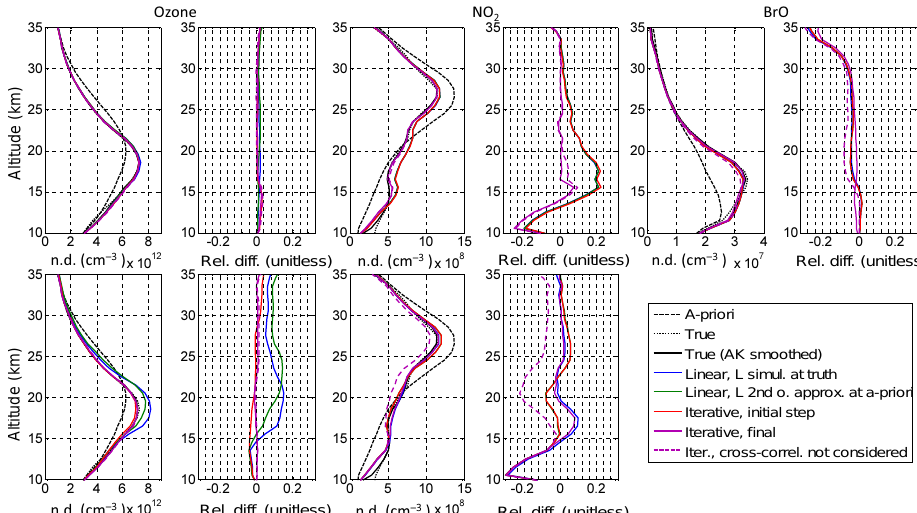
Figure 13. Odd plots (from left for ozone, NO 2 , and BrO): vertical concentration profiles retrieved by different approaches (blue: linear approach with effective light paths simulated for the true profiles; green: same but with effective light paths calculated for the a priori profiles from the first- and second-order absorption terms simulated at zero absorption background; red: profile retrieved at the initial step of the iterative algorithm; magenta solid line: final profile obtained by the iterative approach; magenta dotted line: final profile but without consideration of the cross-correlative terms between different absorbers) in comparison with the true profile (black dotted line: original profile; black solid line: original profile smoothed by averaging kernels). The a priori is shown as a dashed line. Even plots: relative difference to the true profiles smoothed by the averaging kernels. Top: results for the UV; bottom: results for the